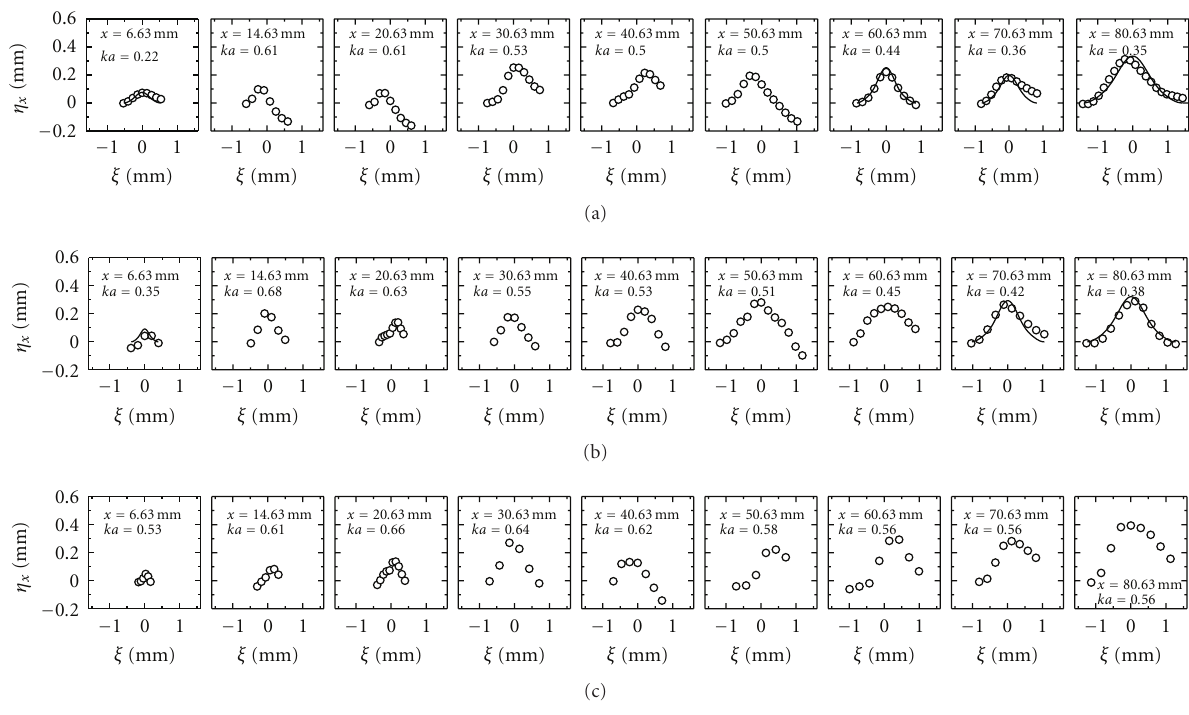
Figure 11: Examples of observed waveforms for U = 6,8, and 10m/s ( R th = 0 .